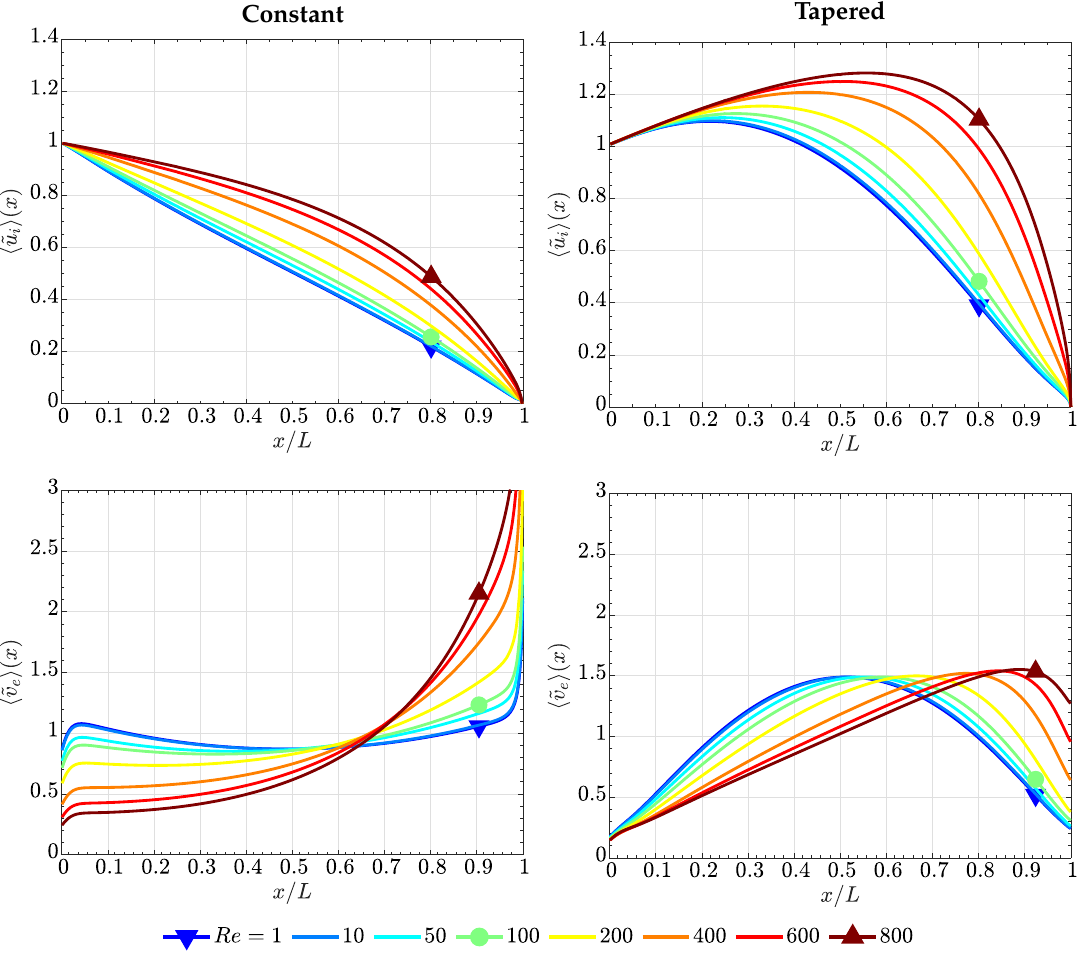
Figure 2. Variation of ( top ) the y -averaged axial velocity in the inlet channel, (cid:104) ˜ u i (cid:105) ( x ) , and ( down ) the y -averaged transverse velocity in the electrode, (cid:104) ˜ v e (cid:105) ( x ) , as a function of the along-the-channel coordinate, x / L , for Re = 1–800, corresponding to ( left ) the constant cross-section and ( right )